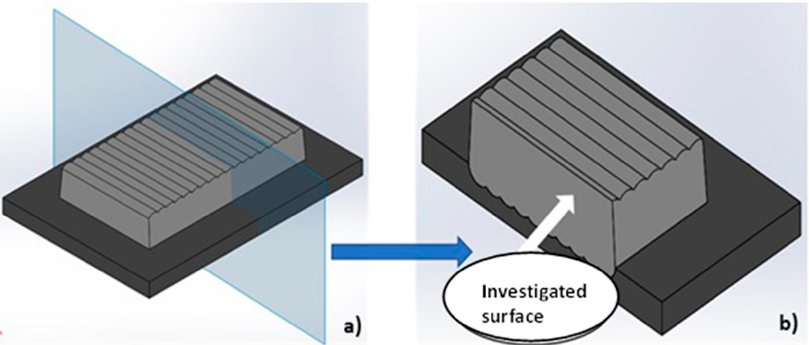
Figure 4. Schematic representation showing the microstructural evolution and hardness measure- ments scenario: ( a ) cut section at the middle of the WAAM prismatic block; ( b ) microstructural evolution and hardness testing along the building direction.